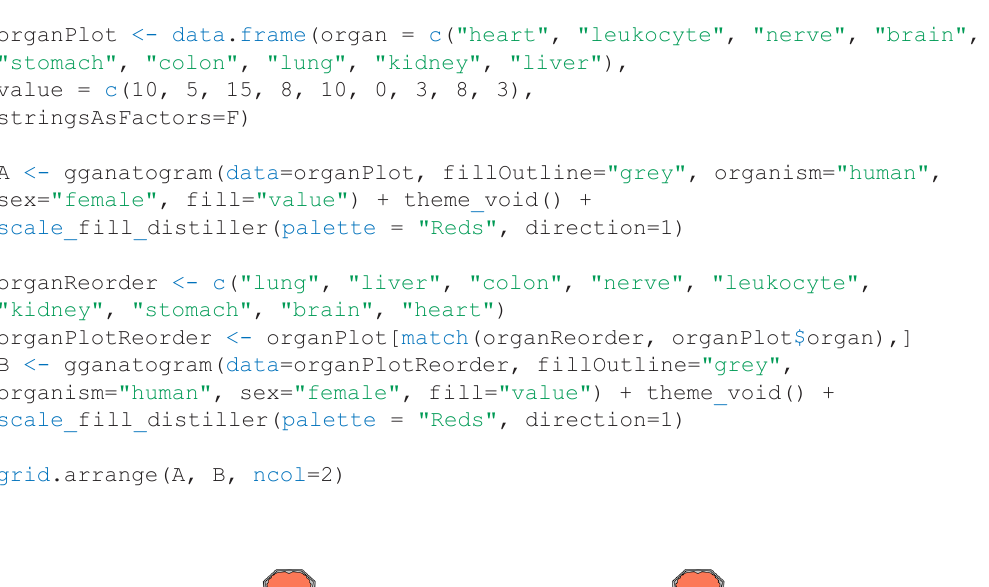
To change the order of how organs are layered on top of each other, change the order of the data frame. The organs to plot on the top layer should be on the end of the data frame (Figure 4).